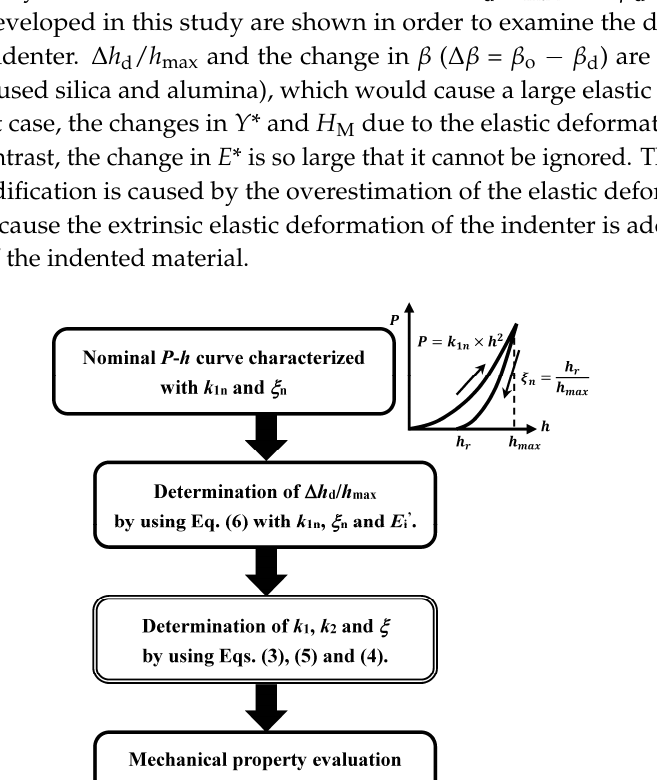
Figure 9. Flow chart of the procedure to evaluate mechanical properties.